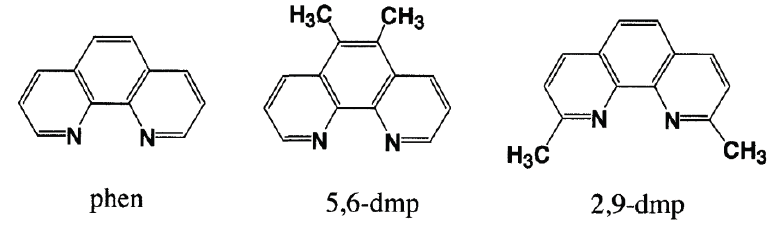
Figure 3. 1,10-phenanthroline (phen) and its methyl